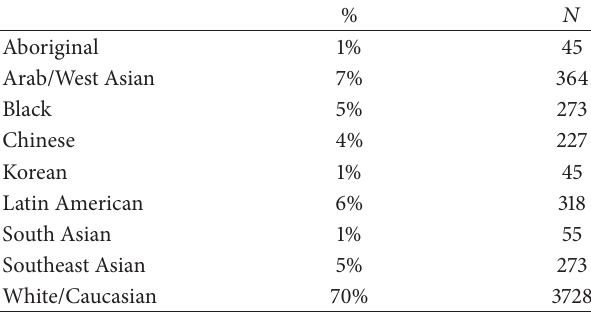
Table 1: Ethnicity of CCRR participants.